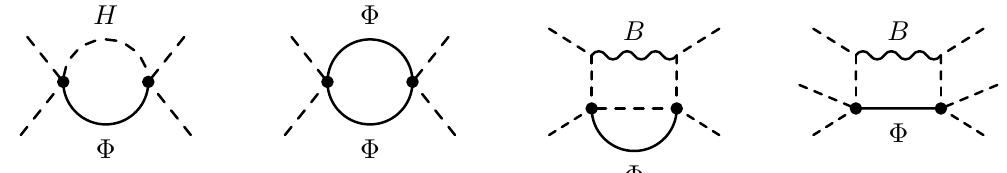
Figure 1 . Illustrative diagrams involved in the loop-level matching of the weak quadruplet models to Higgs operators violating custodial symmetry at dimension-6 and